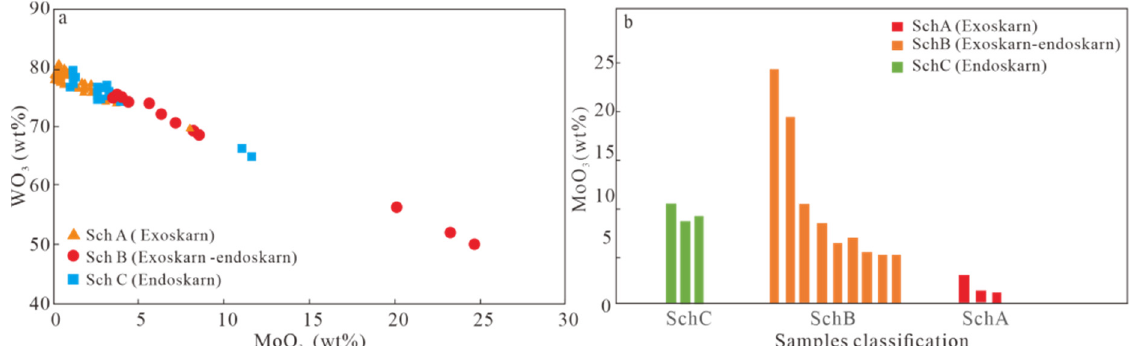
Figure 7. WO 3 vs. MoO 3 contents in SchA-SchC at Tongshankou deposit, showing the relationship between major elements (WO 3 and MoO 3 ) of scheelite. ( a ) Diagram of MoO 3 vs. WO 3 in scheelites from the Tongshankou deposit, showing the negative correlation between WO 3 and MoO 3 ( b ) Histogram of MoO 3 content for SchA, SchB and SchC, showing the various MoO 3 contents.